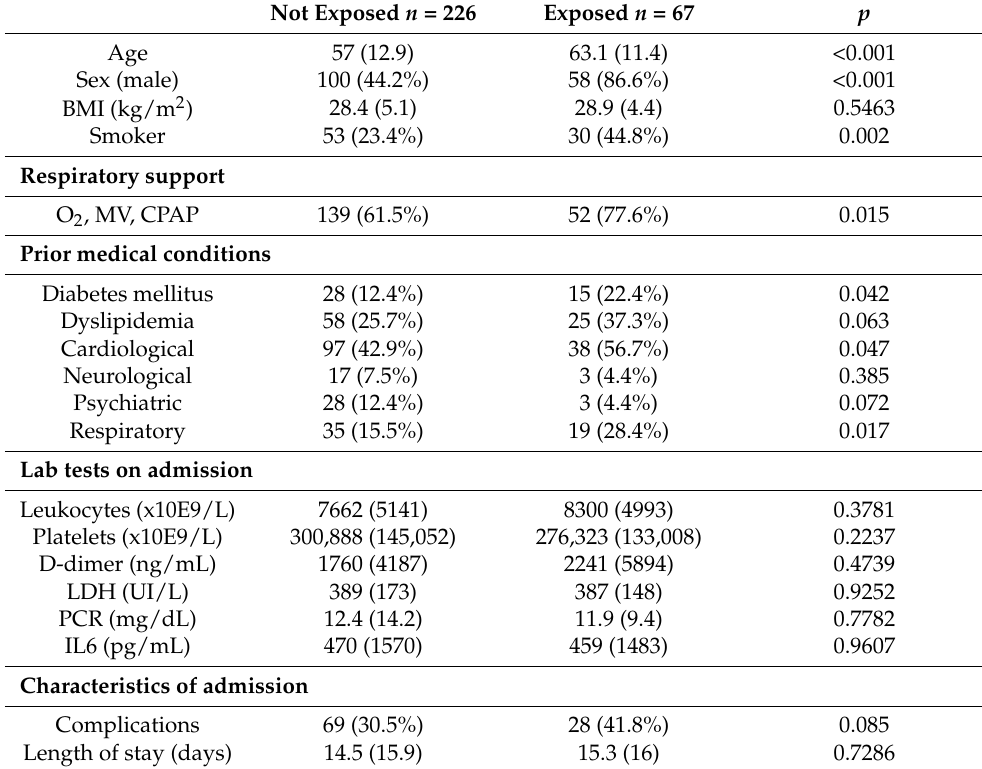
Table 2. Hospital admission data of patients according to occupational exposure to asbestos a .